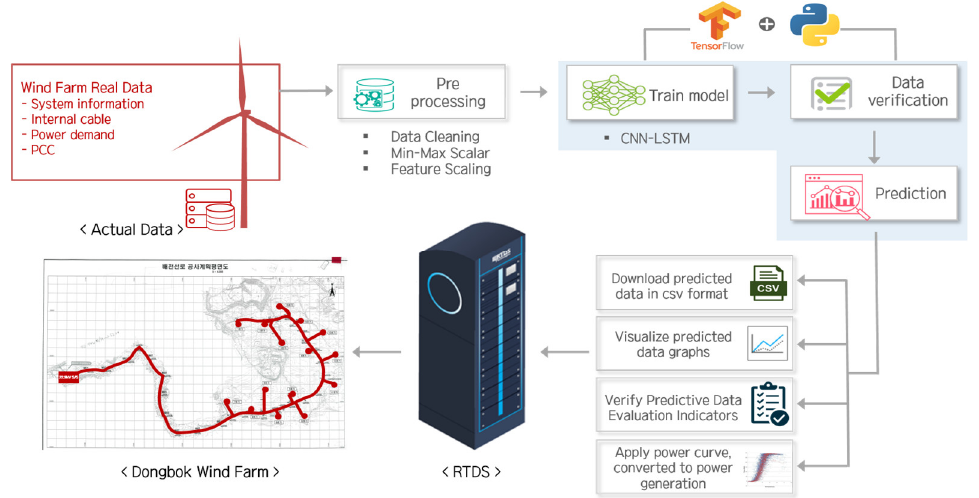
Figure 5. Overall simulation